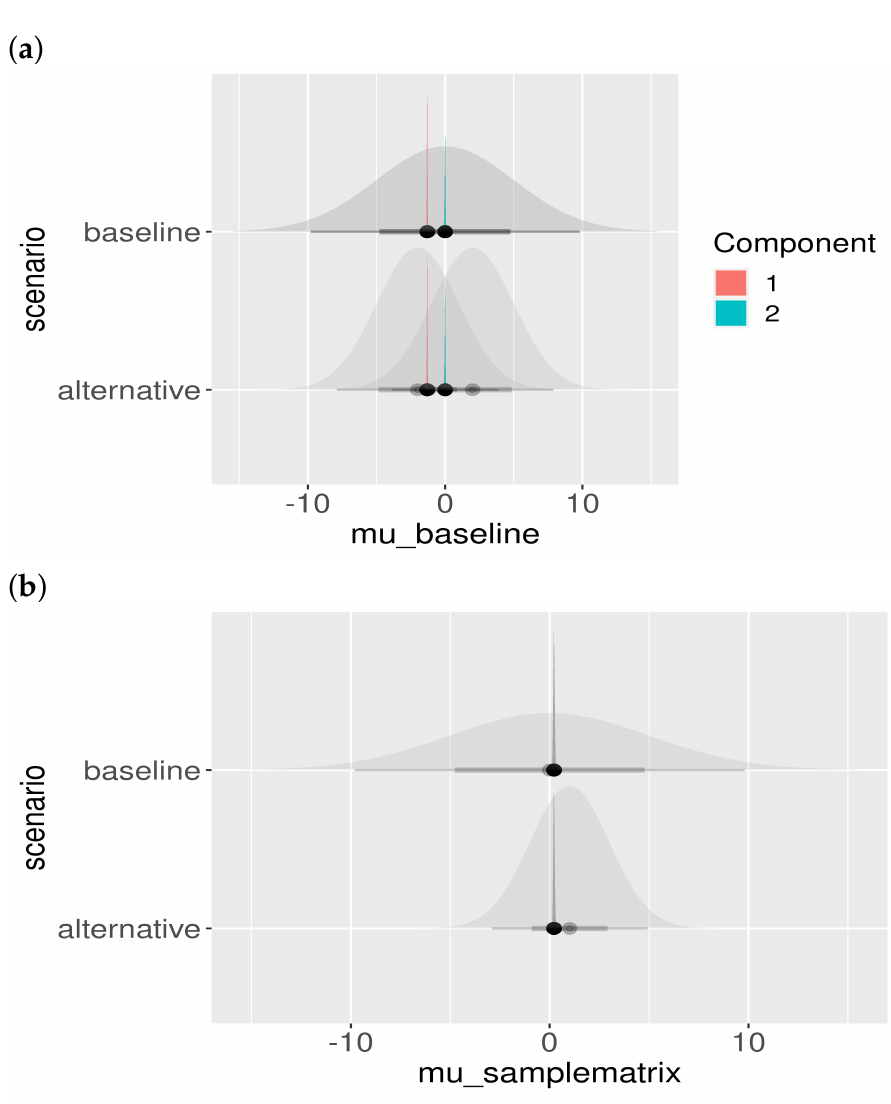
Figure A2. Posterior parameter estimates and prior dependence. The Baseline and alternative scenar- ios are presented in different rows. The shaded priors are uninformative (wide), and the posterior estimates can be seen not to be influenced by the choice of the prior distribution. ( a ) Posteriors of µ baseline+ colored by component, ( b ) Posteriors of µ shift . ( c ) Posteriors of σ , colored by component, ( d ) Posteriors of p study , colored by study.